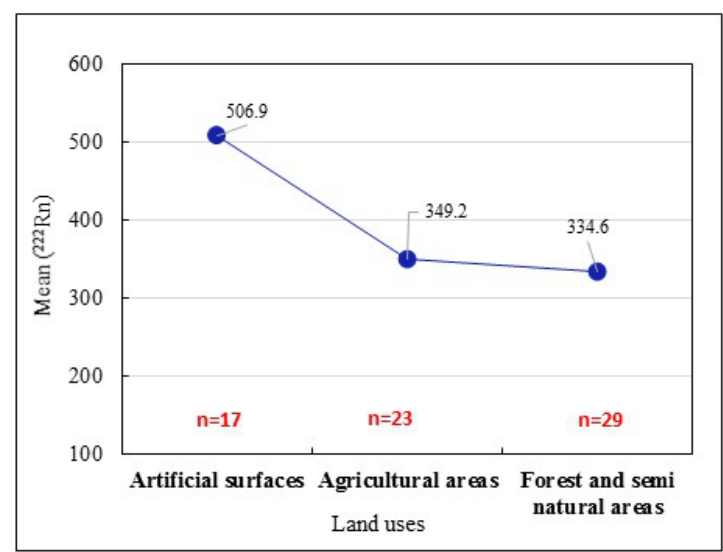
Figure 6. Average radon concentrations for several land-use areas.